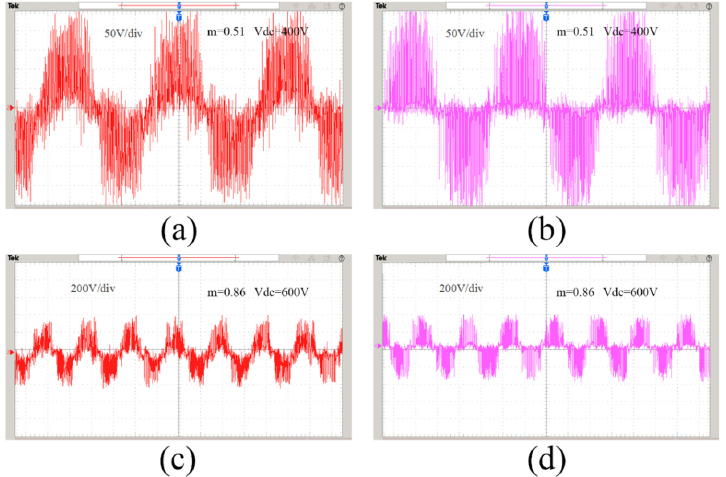
Figure 16. Line-to-neutral voltage experimental waveforms: ( a ) traditional method, m = 0.51, Vdc = 400 V; ( b ) proposed method, m = 0.51, Vdc = 400 V; ( c ) traditional method, m = 0.86, Vdc = 600 V; ( d ) proposed method, m = 0.86, Vdc = 600 V. Vdc = 600 V; ( d ) proposed method, m = 0.86, Vdc = 600 V.